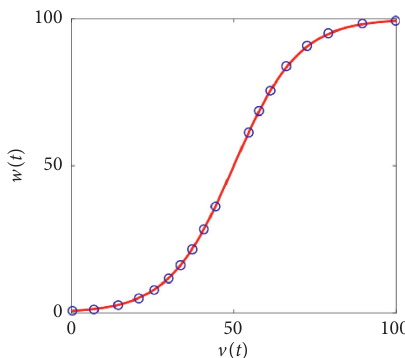
Figure 18: Example 3: comparison between real nonlinear function tansig (red) and captured nonlinearity (blue